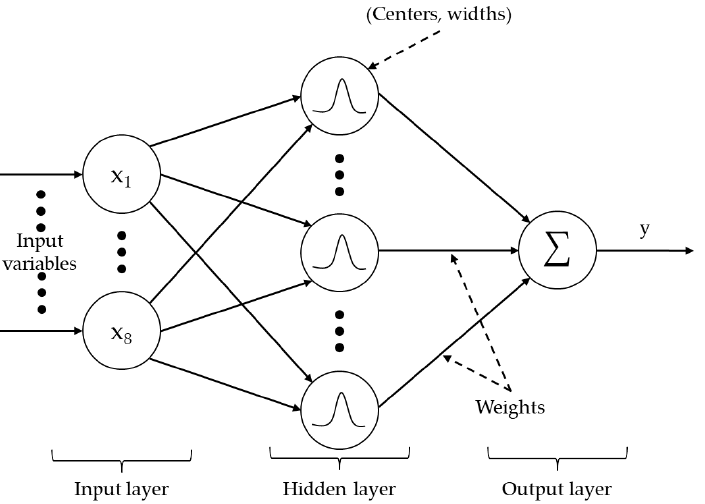
Figure 8. Architecture of a radial basis function network.